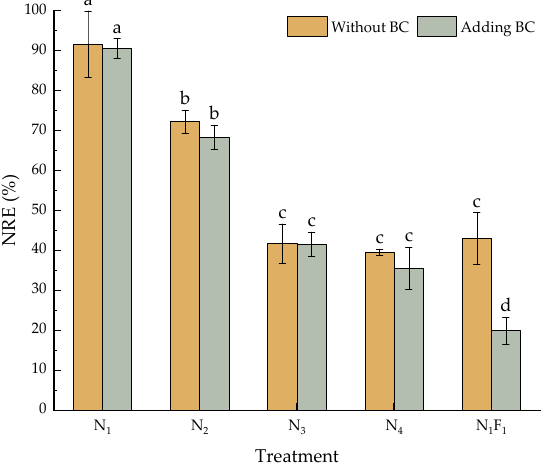
Figure 5. Apparent fertilizer N recovery efficiency ( NRE ). Note: NRE in the graph represents means ± standard errors (n = 5). Different letters represent significant differences ( p < 0.05) in NRE for each treatment between different BC allotment levels, urea application amounts, and organic manure amounts. N 0 , N 1 , N 2 , N 3 , and N 4 represent the urea application rate, 0, 100, 200, 300, and 400 kg N ha − 1 , respectively. F 1 represents organic manure of 100 kg N ha − 1 .